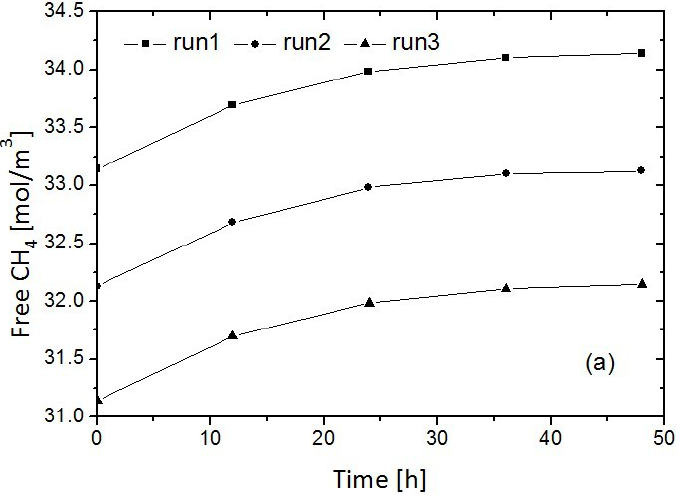
Figure 11. Amount of the replaced CH against